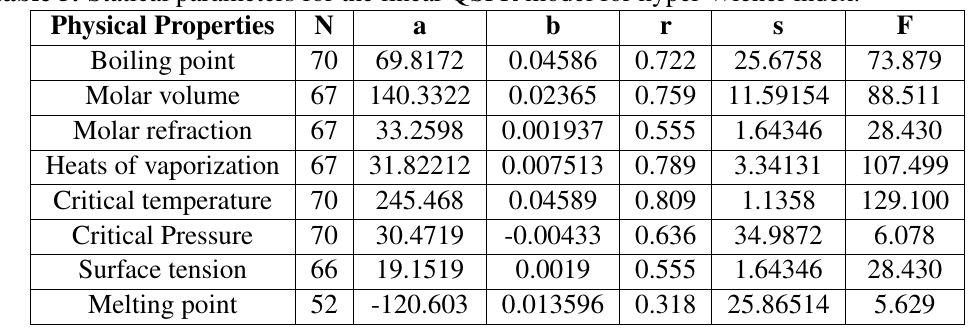
Table 5. Statical parameters for the linear QSPR model for hyper Wiener index.